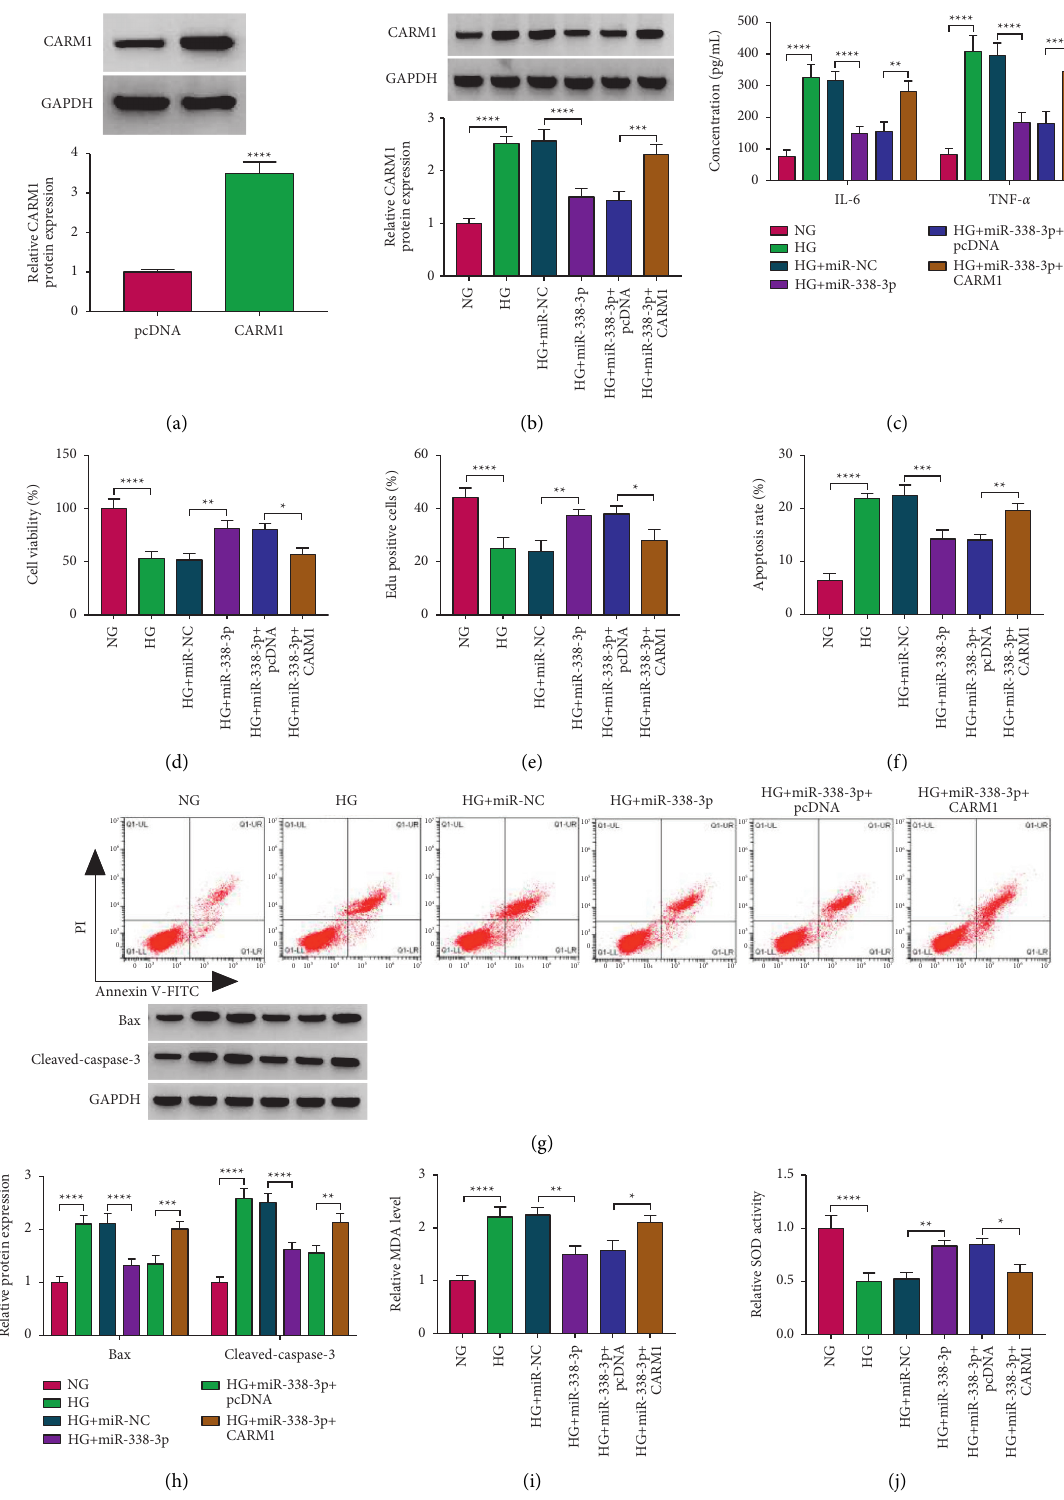
Figure 7: Effects of CARM1 and miR-338-3p on HG-induced ARPE-19 cell injury. (a) The transfection efficiency of pcDNA CARM1 overexpression vector was assessed by detecting CARM1 protein expression using the WB analysis. (b–j) ARPE-19 cells were transfected with miR-NC, miR-338-3p, miR-338-3p +pcDNA, or miR-338-3p+CARM1 and then treated with HG. The cells treated with NG were used as control. (b) The WB analysis was used to measure the protein expression of CARM1. (c) The concentrations of IL-6 and TNF- α were examined using ELISA. Cell proliferation and apoptosis were measured by MTTassay (d), EdU assay (e), and flow cytometry (f, g). (h) The WB analysis was used to detect the protein expression of Bax and cleaved-caspase-3. (i, j) MDA level and SOD activity were determined to assess cell oxidative stress. ∗ P < 0 . 05, ∗∗ P < 0 . 01, ∗∗∗ P < 0 . 001, and ∗∗∗∗ P < 0 .